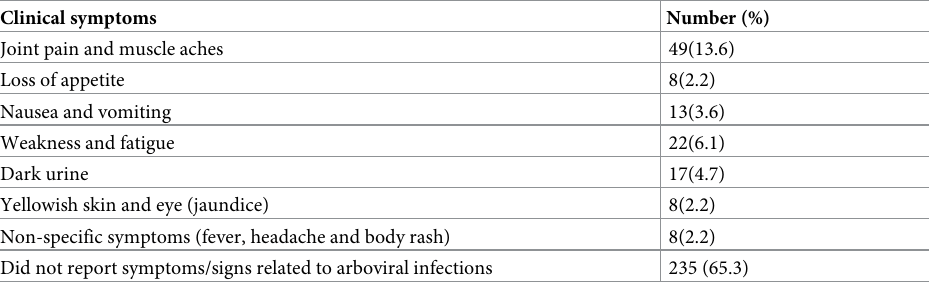
Table 2. Clinical symptoms reported by the participants (N = 360).